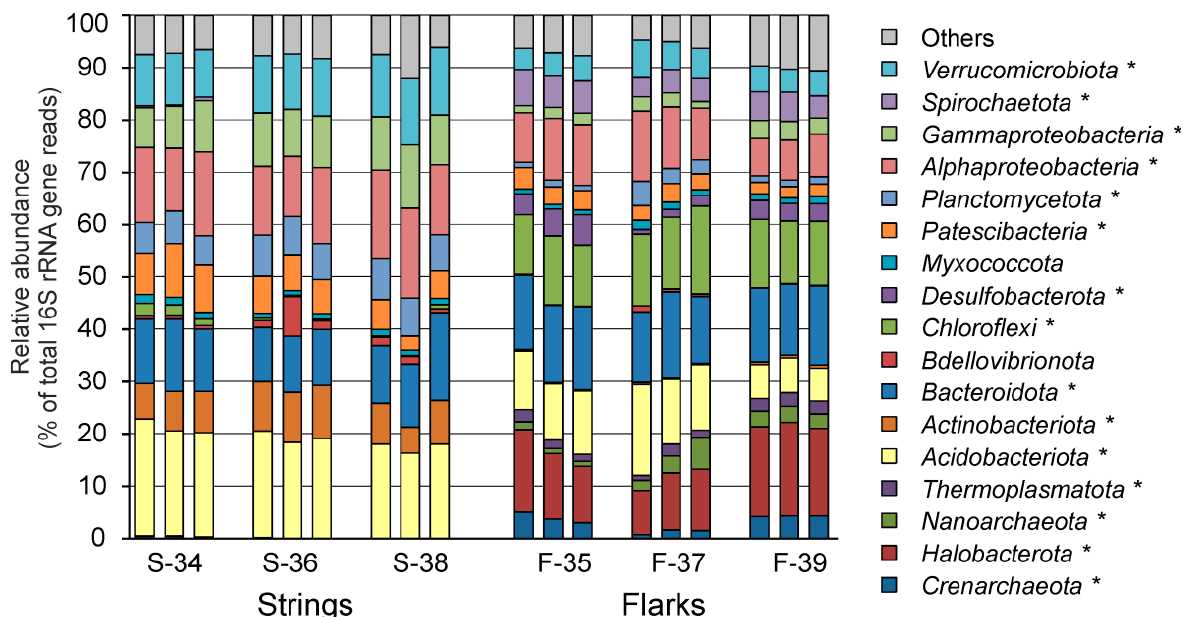
Figure 3. Prokaryotic community composition in string and flark peat samples, according to results of 16S rRNA gene profiling. Community composition is shown at the phylum level, with exception of Proteobacteria , for which classes Alpha- and Gammaproteobacteria are shown. All replicate samples (three per sampling site) are presented. Lineages with statistically significant differences ( p < 0.05) in relative abundance in strings and flarks are marked with an asterisk.